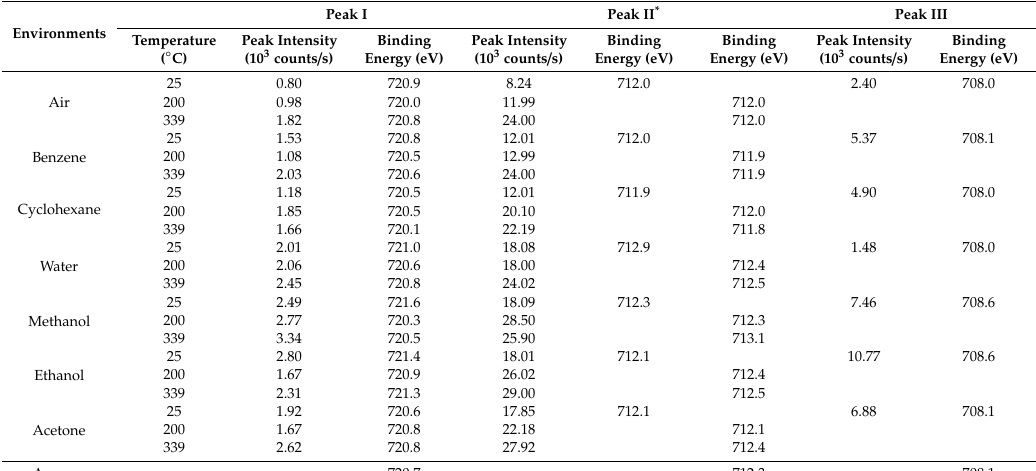
Table 1. The intensities and binding energies of Peaks I, II, and III observed in Fe 2 p spectra at three temperatures for iron surfaces scratched in di ff erent